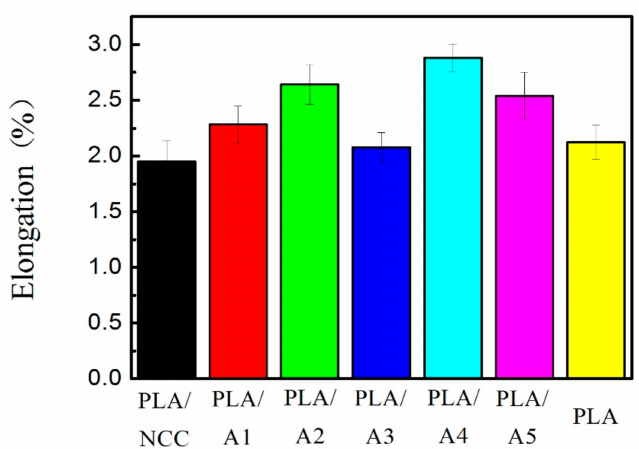
Figure 8. Elongation at break of PLA / NCC-HAP films with di ff erent ratios of NCC to HAP.